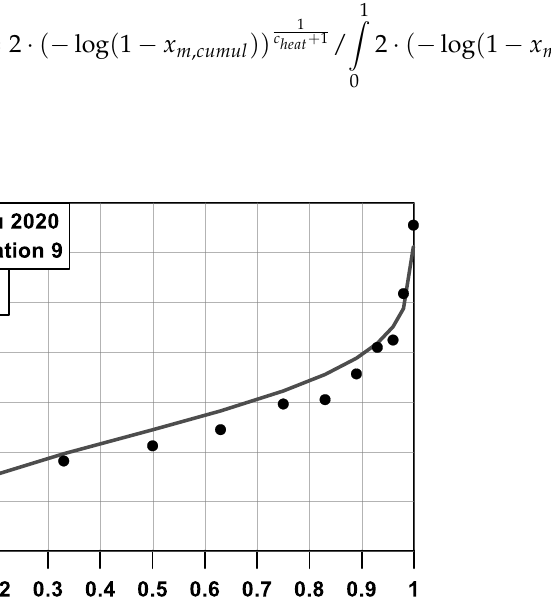
Figure 4. Comparison between [29] and Equation (9) heat transfer fraction per mass unit profiles versus the cumulative mass fraction.